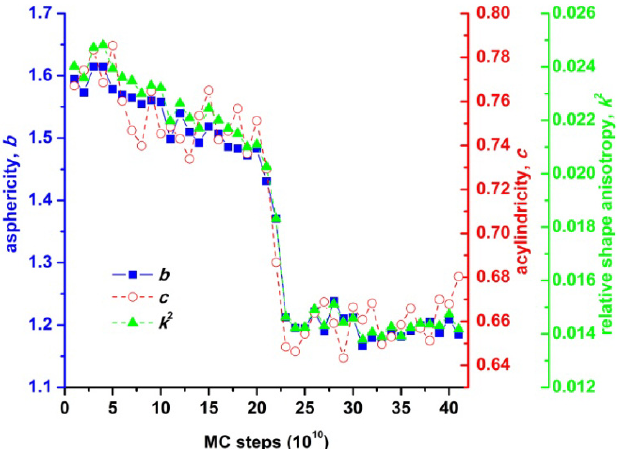
Figure 12. Average asphericity, b , acylindricity, c , and relative shape anisotropy, k 2 , as a function of MC steps from simulations of freely-jointed chains of tangent hard spheres ( N = 12 with uniform distribution of chain lengths) at . Global shape measures φ 0.61 are averaged over all 1200 coarse-grained ellipsoids, each one having semi-axes as obtained from the eigenvalues of the moment of inertia tensor of the corresponding Voronoi polyhedron.